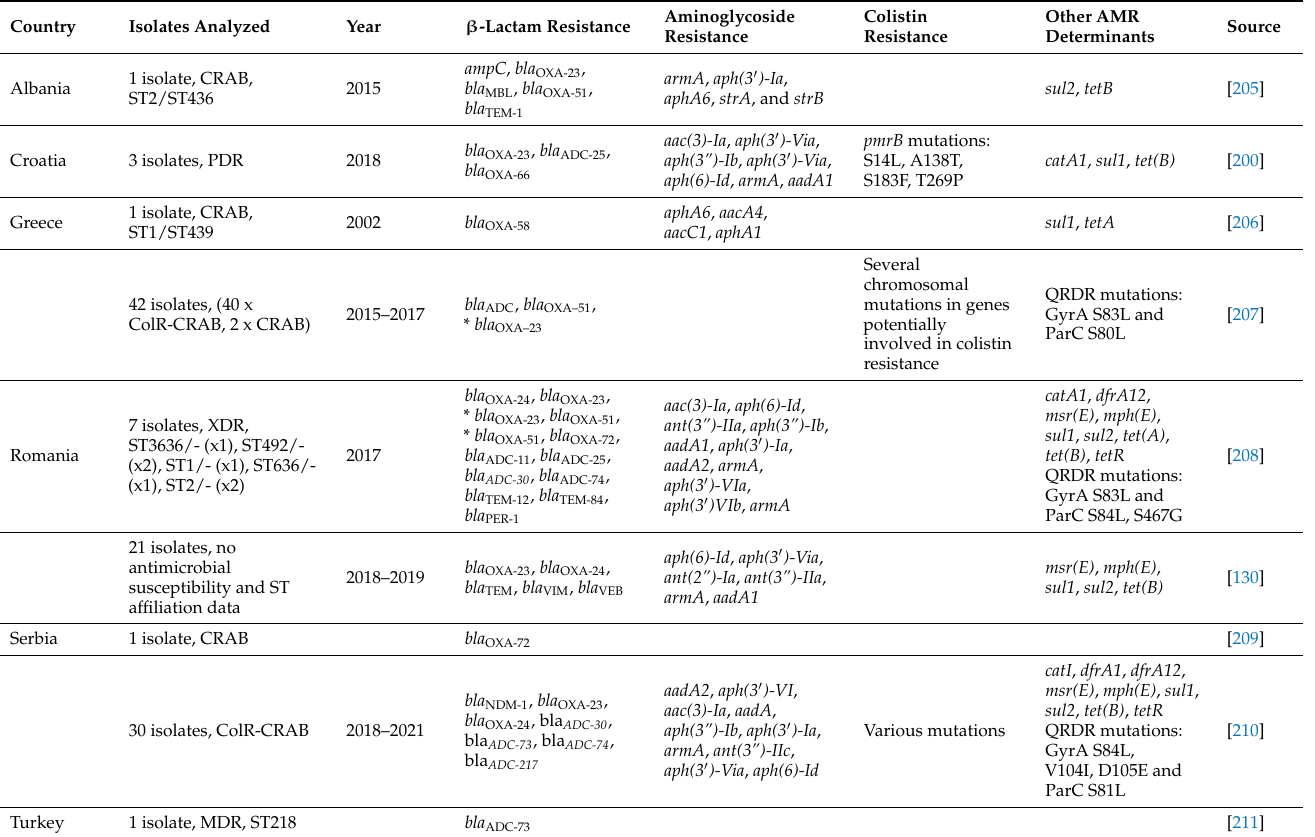
Table 2. Whole-genome sequencing-based resistome studies of MDR, XDR, PDR, and colistin-resistant A. baumannii isolates from the